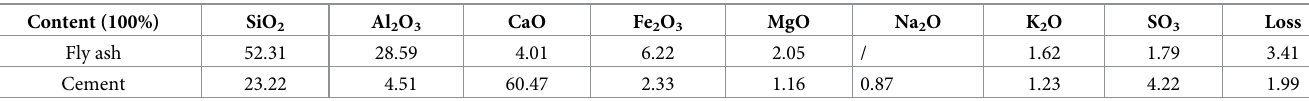
Table 1. Chemical composition of the fly ash and